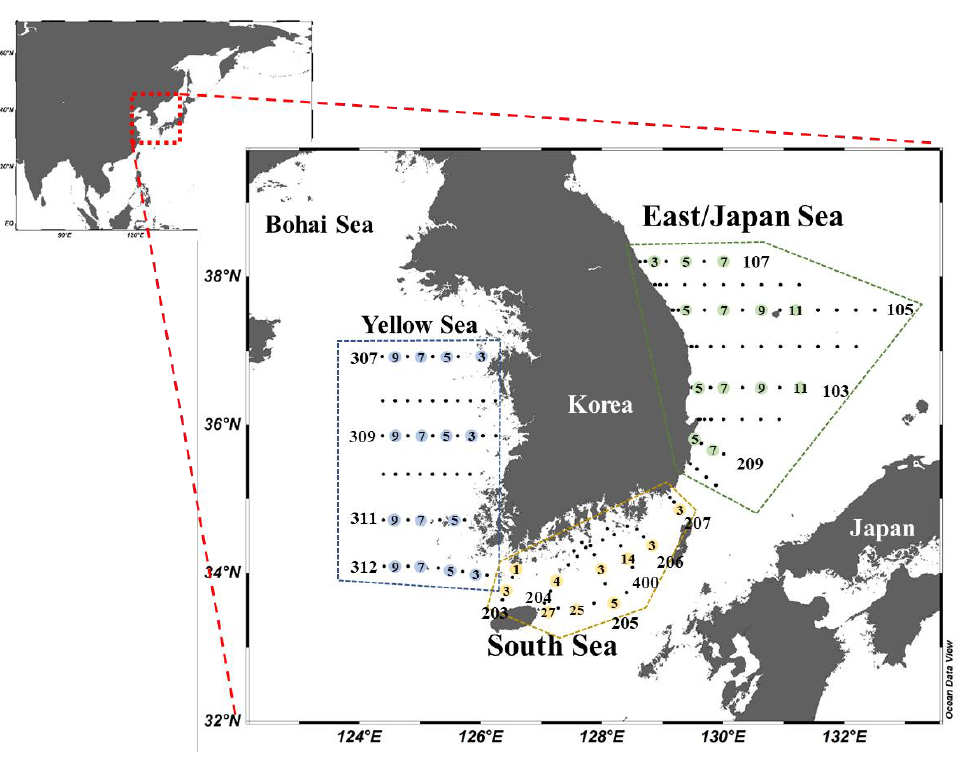
Figure 1. Locations of sampling regions in 2018. The station numbers are in consecutive order from coast to open sea as marked in each station line. Table 1. Description of sampling sites in the YS, the SS, and the EJS for each cruise period, in 2018. (o) means investigation was conducted, while (-) means investigation was not conducted.